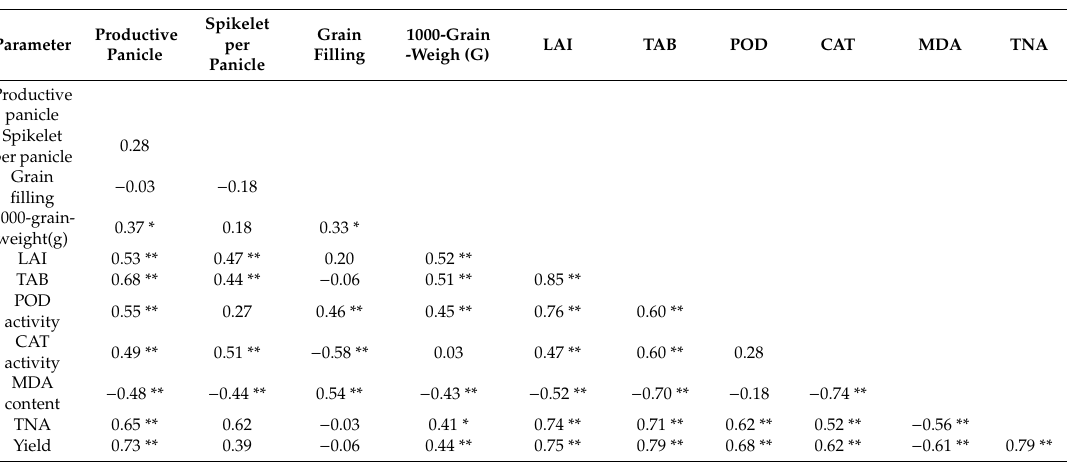
Table 3. Relationship among grain yield, and its components, TAB, TNA, LAI, and antioxidant enzyme activities for both rice cultivars (2018 and